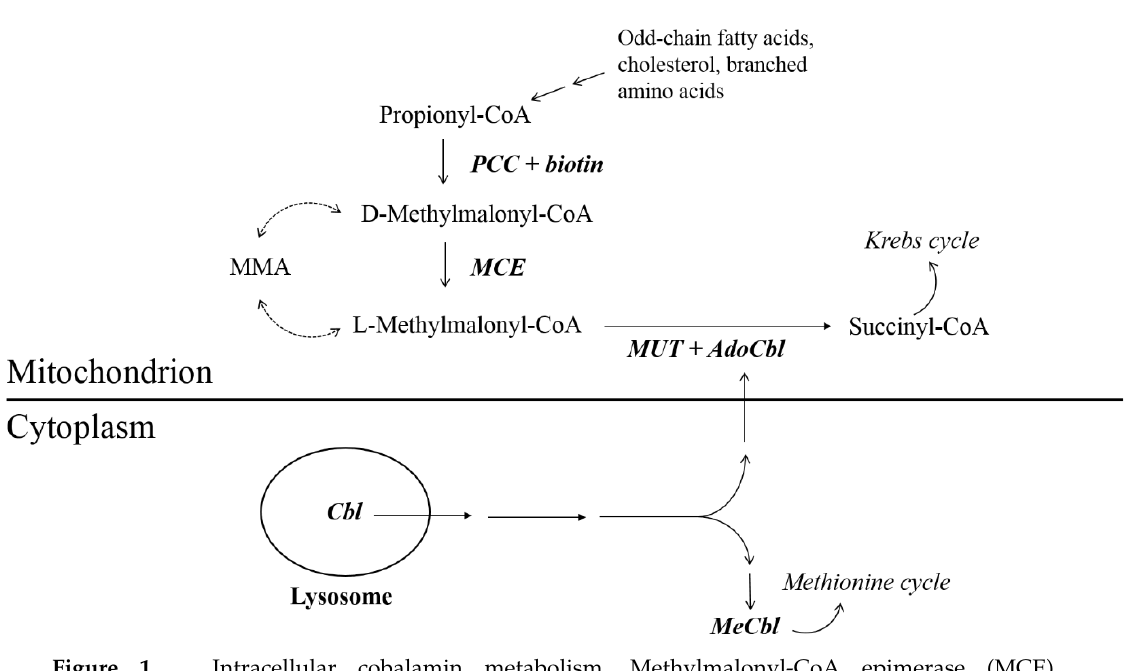
Figure 1. Intracellular cobalamin metabolism. Methylmalonyl-CoA epimerase (MCE) deficiency